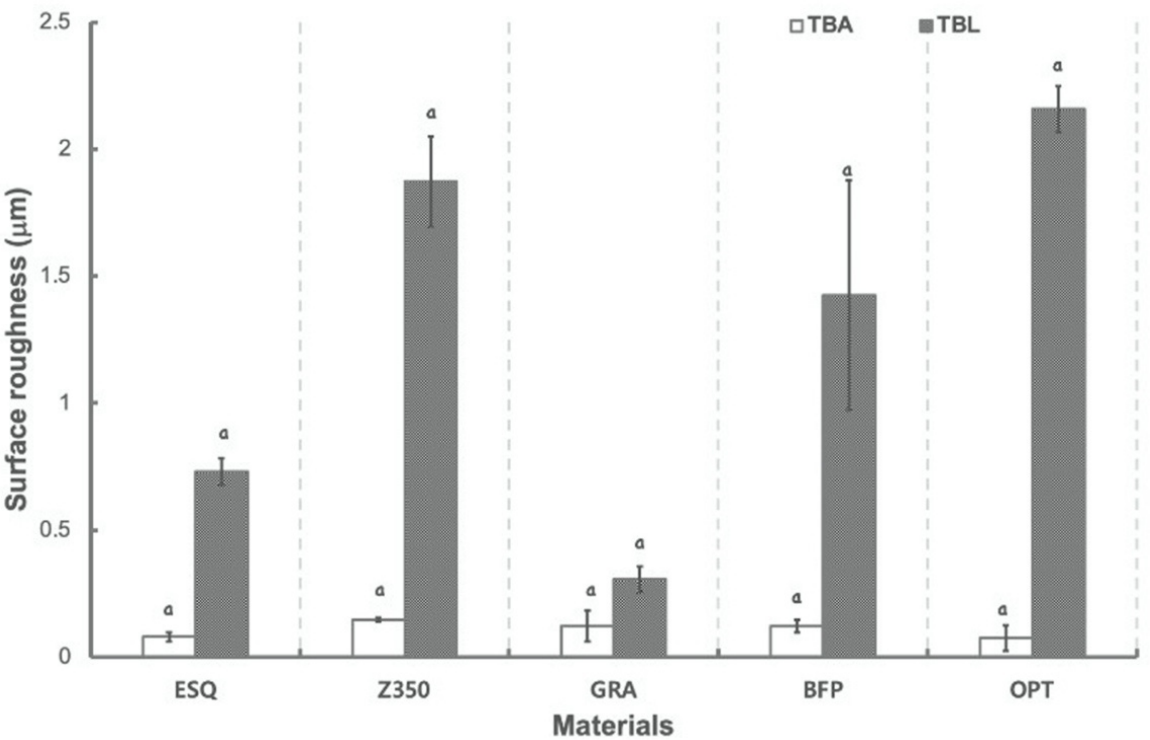
Figure 1. Mean and standard deviation values of surface roughness for each material before (TBA) and after (TBL) bleaching. Same lowercase letter indicates a static difference between time points for each material.